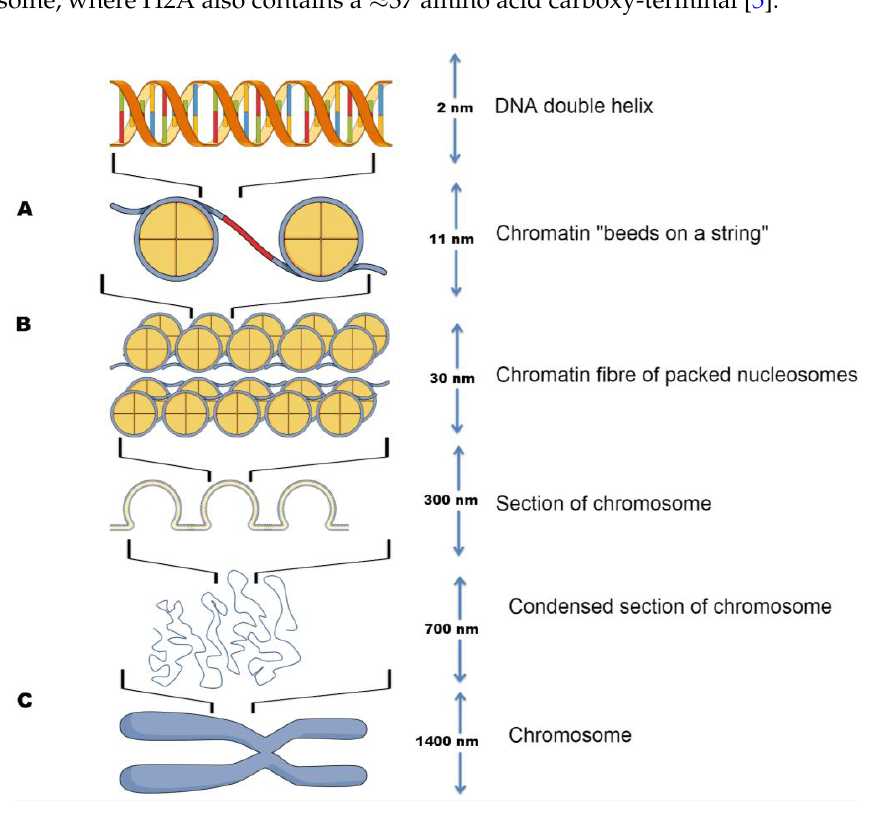
Figure 1. Schematic of DNA compaction levels facilitated by nucleosomes. Left: ( A ) DNA wound around the histone octamer, forming a nucleosome. ( B ) Nucleosomes aggregated into chromatin fibres, which compile into higher order three-dimensional loops and domains. ( C ) Chromatin fibres assembling into chromosomes. Right: indication of the scale of each successive structures compaction.